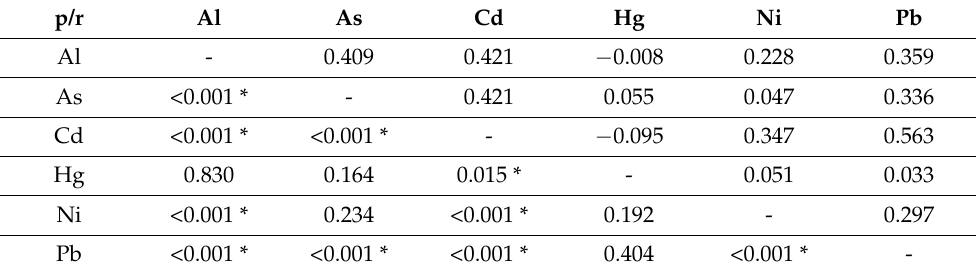
Table 5. Correlation between hair metal levels in the studied cohort.